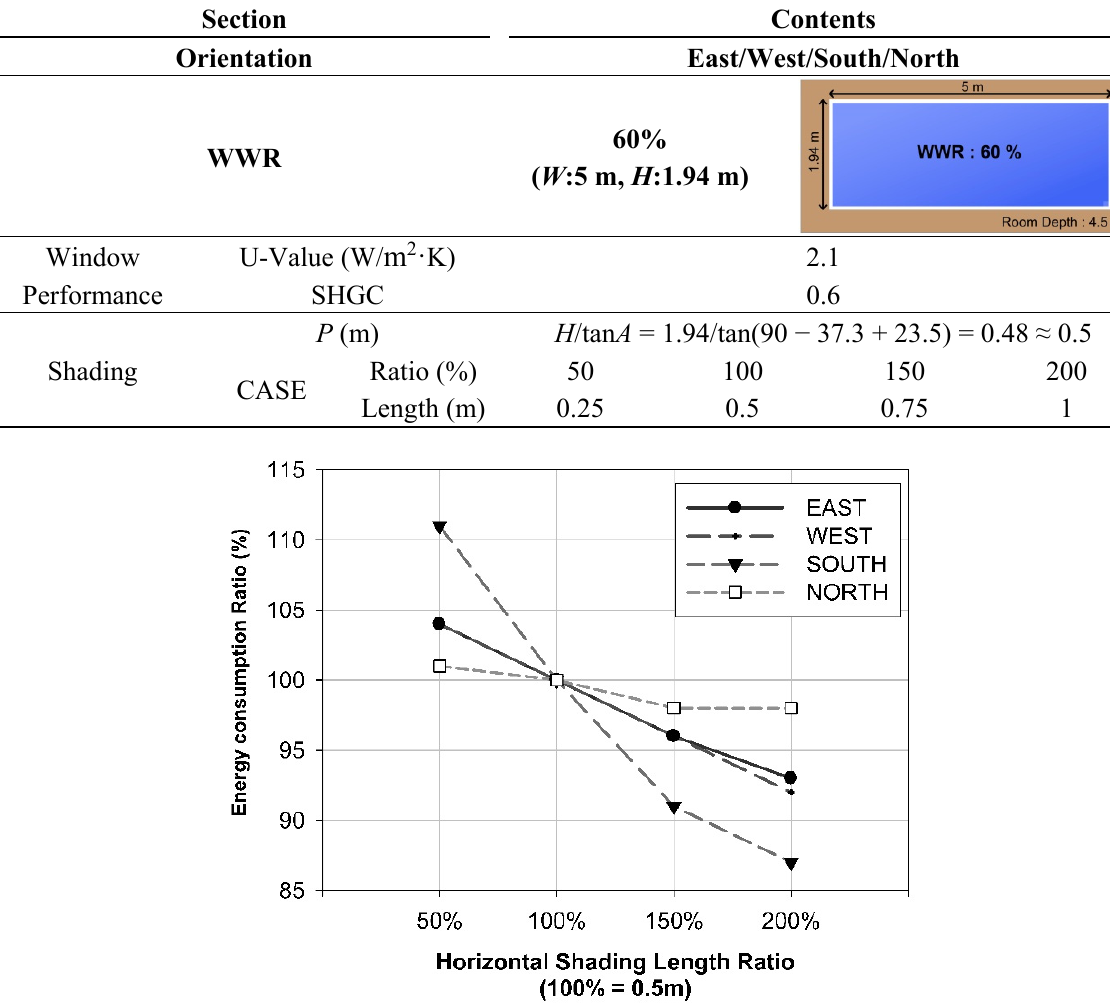
Figure 7. Ratio variation of the heating and cooling load with shading